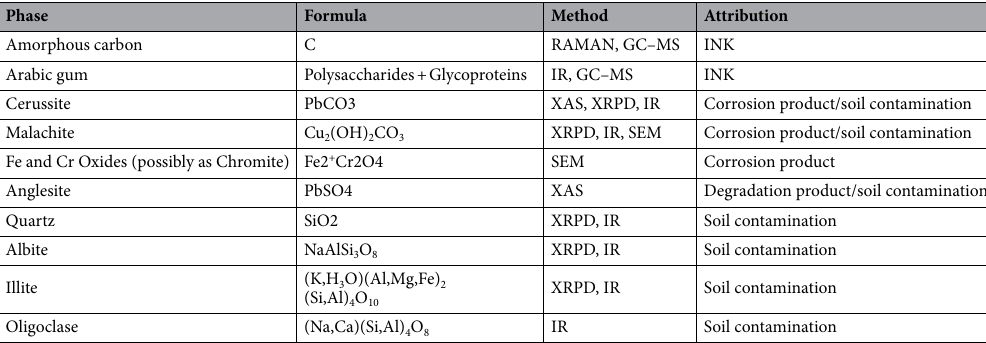
Table 1. Summary of the ink composition, as revealed by the different methods applied for the analysis, and attribution of the specific constituents to original ink composition, corrosion products and soil contamination.